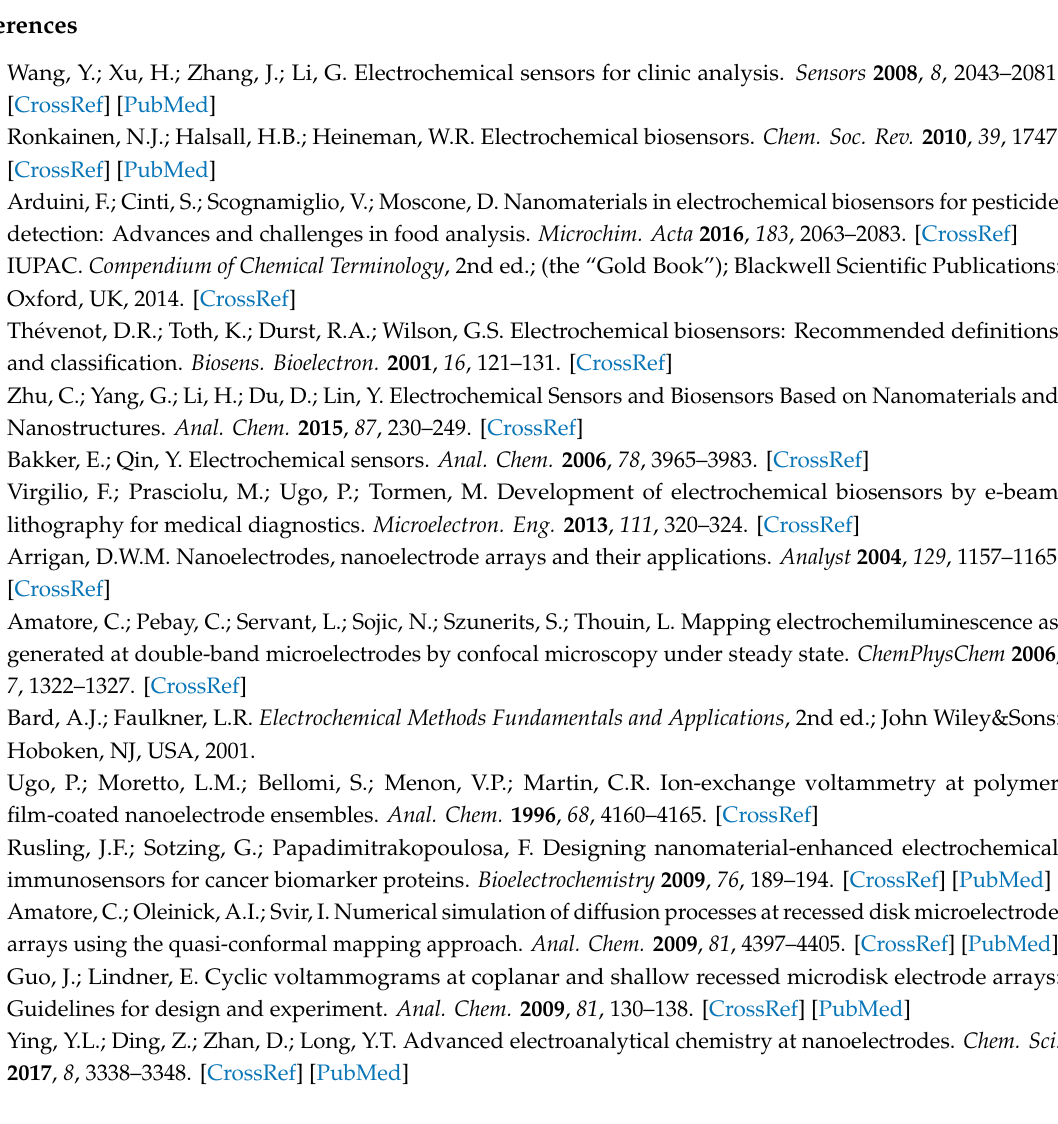
Figure S1: AFM characterization, Figure S2: Gliadin-NEA performance during